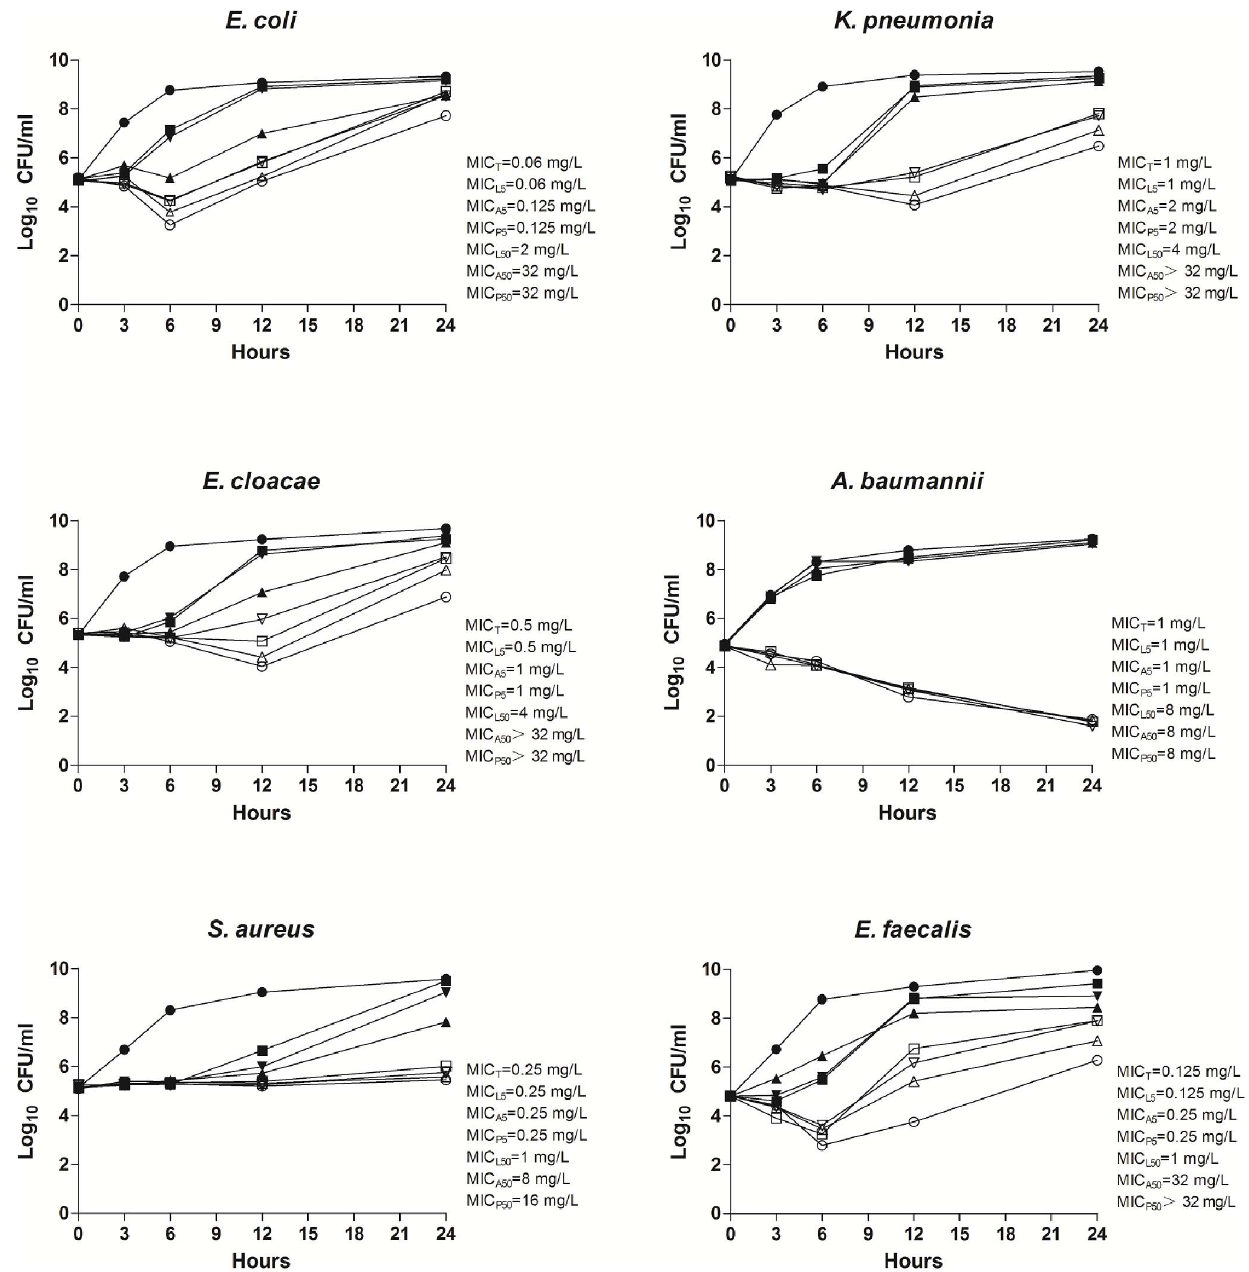
Figure 1. Time–kill curves showing effects of proton pump inhibitors (PPIs) on the activity of tigecycline. MIC T , MIC for tigecycline N alone; MIC L5 and MIC L50 , MIC for tigecycline in combination with 5 mg/L and 50 mg/L lansoprazole; MIC A5 and MIC A50 , MIC for tigecycline in , combination with 5 mg/L and 50 mg/L omeprazole; MIC P5 and MIC P50 , MIC for tigecycline in combination with 5 mg/L and 50 mg/L pantoprazole. Control; m , 50 mg/L lansoprazole; . , 50 mg/L omeprazole; & , 50 mg/L pantoprazole; D , 5 mg/L lansoprazole; h , 5 mg/L omeprazole; % , 5 mg/L pantoprazole; # , tigecycline alone. The in vitro time-kill experiments were duplicated; mean values are plotted. In all duplicate experiments, similar time-kill results were obtained. doi:10.1371/journal.pone.0086715.g001 different species of pathogens. For example, after addition of of lansoprazole 30 mg twice daily, the C max in plasma among 50 mg/L omeprazole, the MIC 50 of E. coli increased by 128-fold healthy volunteers were approximately 1.45–2.2 mg/L. [10] And after intravenous administration of omeprazole 40 mg every 24 h, while the MIC 50 of S. aureus increased by 32-fold, as shown in the mean C max in plasma were 2.51 6 0.65 mg/L in individuals with homozygous extensive metabolizer and 3.45 6 0.65 mg/L in The influence of PPIs on in vitro susceptibilities of tigecycline those with poor metabolizer. [11] In our study, we found that an suggests that the concomitant use of PPIs may weaken its addition of 5 mg/L lansoprazole or omeprazole had no or little antibacterial activity in the clinic. After intravenous administration